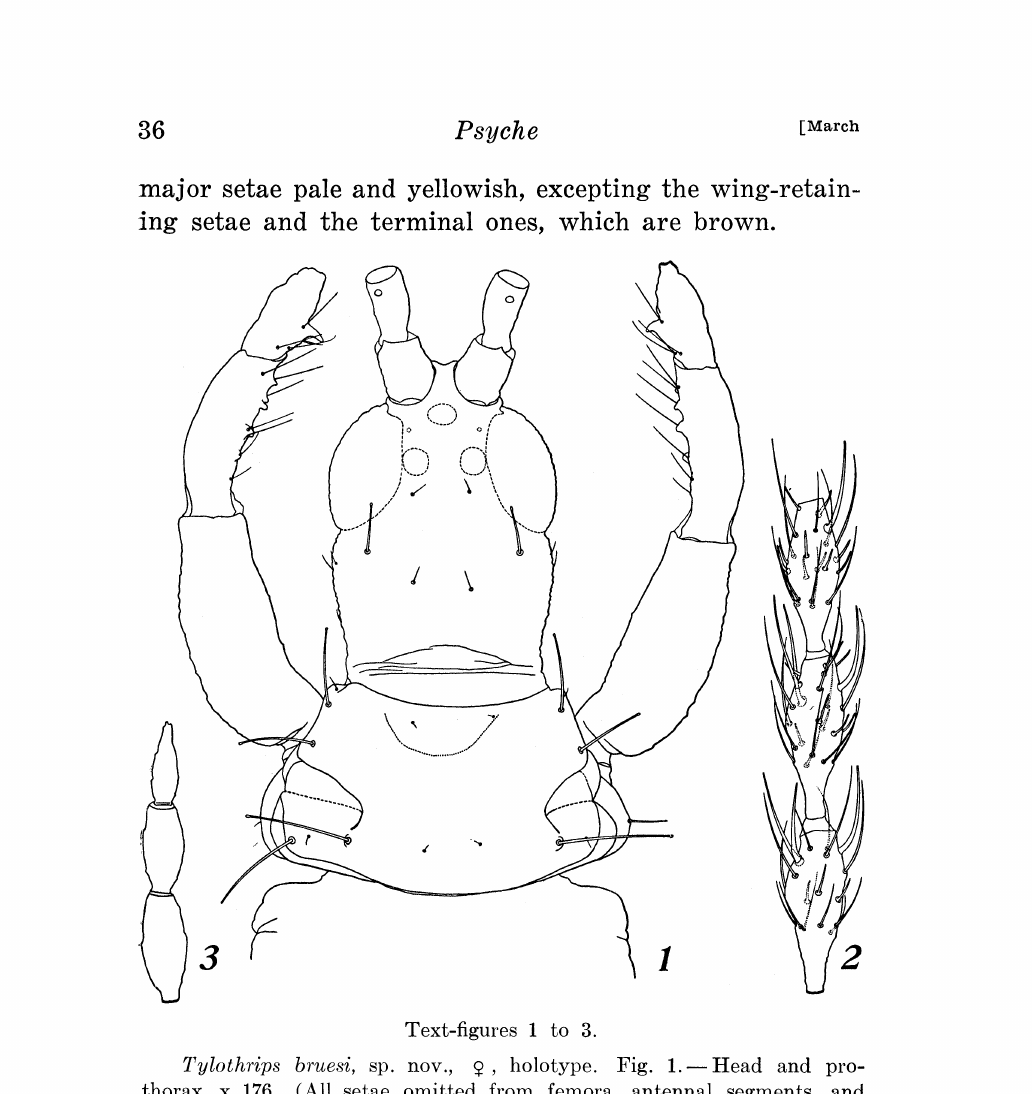
Fig. 3.--Segments w-wH, right antenna, x 236 (all setae